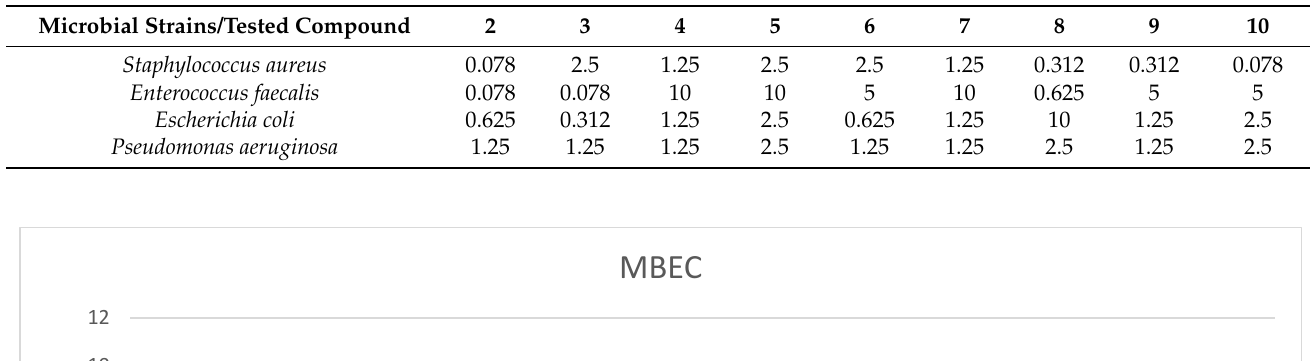
Figure 7. MIC concentrations of the tested compounds against the tested strains.